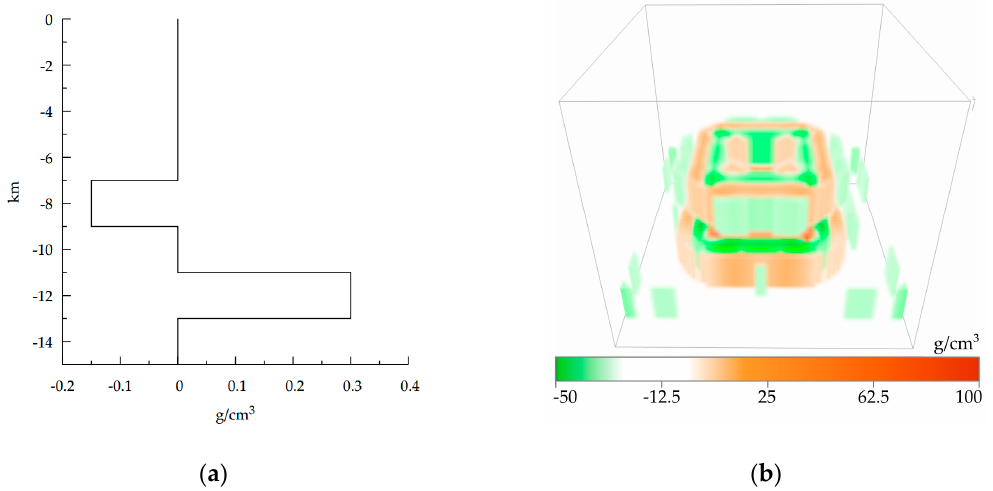
Figure 9. Synthetic example modification #4: ( a ) Background density distribution ρ 0 ( z ) and ( b ) Linear problem inverse solution, which is based on it.